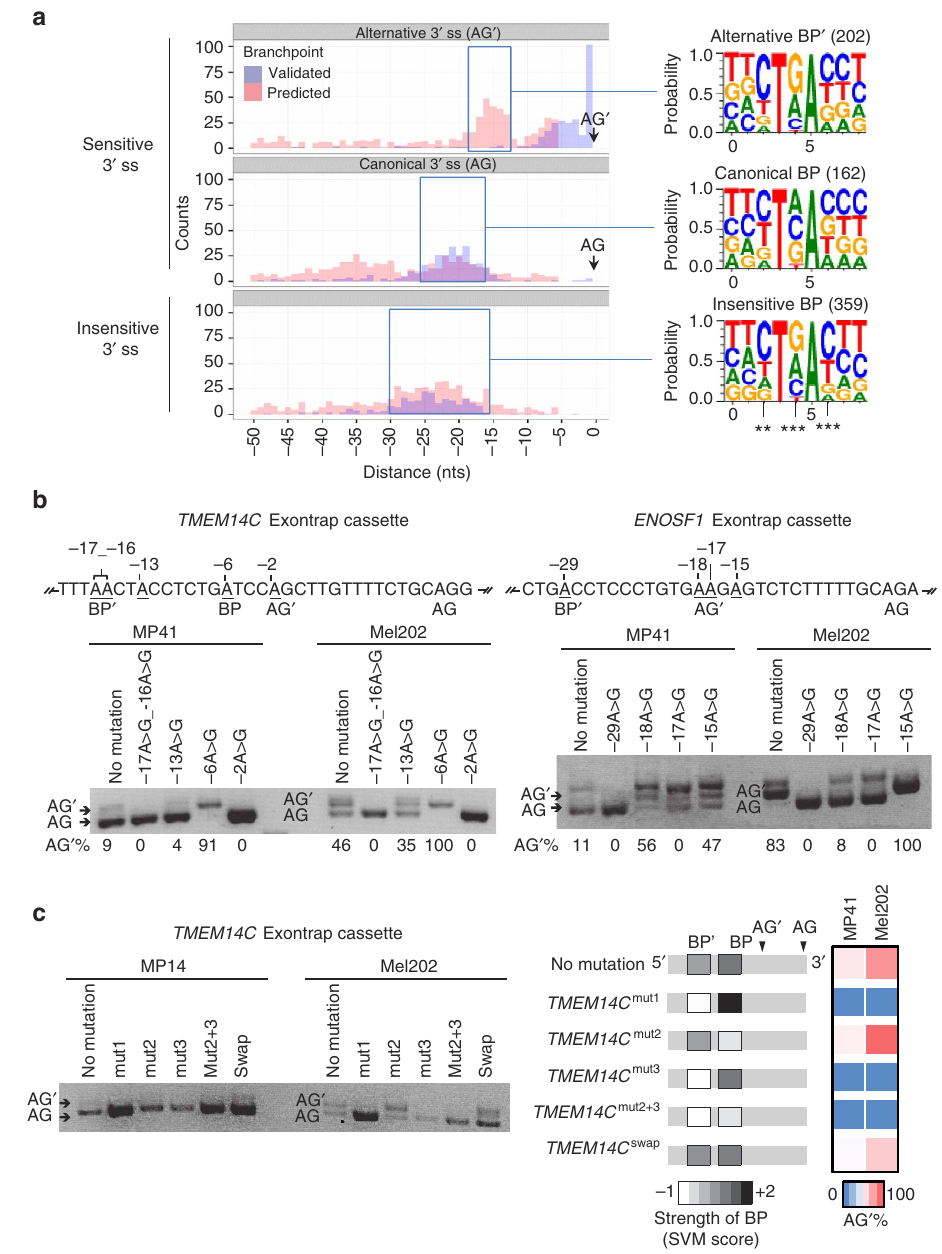
Figure 5 | Identification of alternative branchpoint usage in an SF3B1 MUT context. ( a ) Analysis of distances between the branchpoints and the associated alternative (AG’), canonical (AG) or insensitive 3 0 ss. Left panel: Zero represents the position of the AG’, AG or insensitive 3 0 ss. Red bars represent the clusters of branchpoints predicted by the tool of SVM, blue bars represent the experimentally determined BP data set reported by Mercer et al. 13 . Right panel: the extracted branchpoint sequence logos generated by WebLogo. **Significantly different in the three branchpoint patterns ( w 2 test, P o 0.01), ***Significantly different in the three branchpoint patterns ( w 2 test, P o 0.001). ( b ) Point mutations of branchpoints in TMEM14C and ENOSF1 ExonTrap constructs. All adenosines within a region of 30 nts preceding the canonical AG were mutated into guanines. Mutant constructs were expressed in MP41 ( SF3B1 WT ) and Mel202 (SF3B1 MUT ) cells followed by RT–qPCR. The lower band corresponds to the variant generated by the usage of the canonical 3 0 ss (AG). The intermediate band corresponds to the variant generated by the usage of the alternative 3 0 ss (AG’). The upper band is the heteroduplex formation from two bands (AG and AG 0 ). The numbers represent the ratio of AG’ usage as determined by capillary electrophoresis. ( c ) Base-pairing potential mutants of TMEM14C . Mutant constructs (sequences shown in Supplementary Fig. 5) were expressed in MP41 ( SF3B1 WT ) and Mel202 ( SF3B1 MUT ) cells followed by RT–qPCR. The lower band corresponds to the variant generated by the usage of the canonical 3 0 ss (AG). The upper band corresponds to the variant generated by the usage of the alternative 3 0 ss (AG’). A schematic presentation of the strength of the resulting branchpoints as estimated by their SVM score is shown on the right panel. The ratio of AG’ usage as determined by capillary electrophoresis in MP41 and Mel202 cells is shown as a heat ( TMEM14C swap ) decreased AG 0